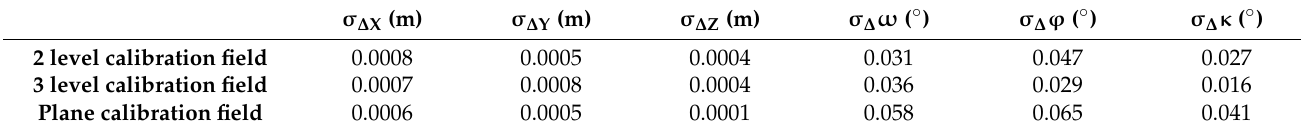
Table 7. The standard deviation of the mean of parameters ∆ X, ∆ Y, ∆ Z, ∆ ω , ∆ ϕ , ∆ κ